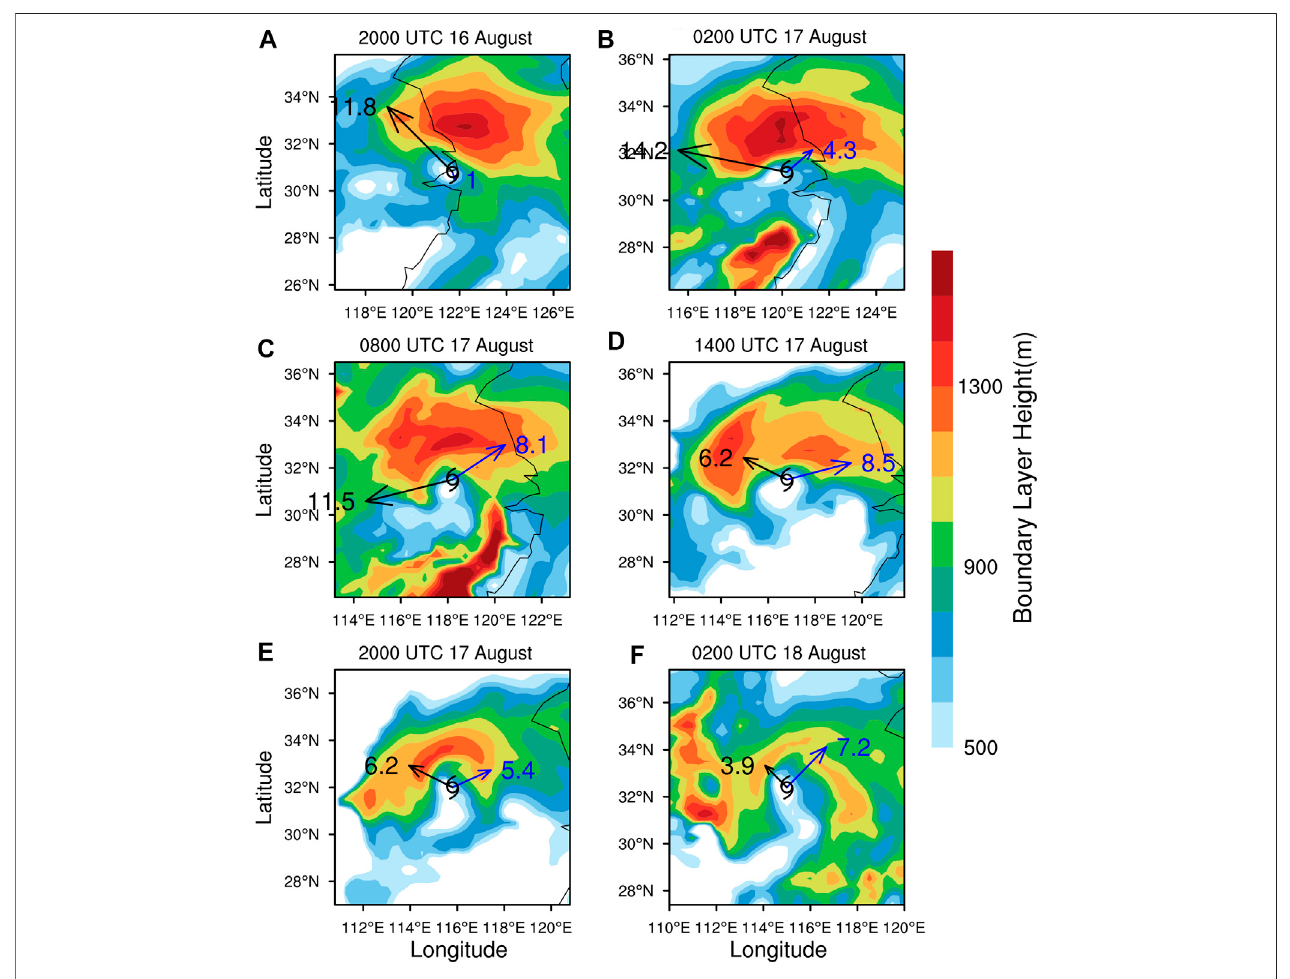
FIGURE 14 | Boundary layer height (shading, m): (A) 2000 UTC 16 August, (B) 0200, (C) 0800, (D) 1,400, (E) 2000 UTC 17 August, (F) 0200 UTC 18 August. Black arrows and numbers denote the storm motion vectors and speeds. Blue arrows and numbers refer to the directions and magnitudes of the deep layer VWS between 300 and 850